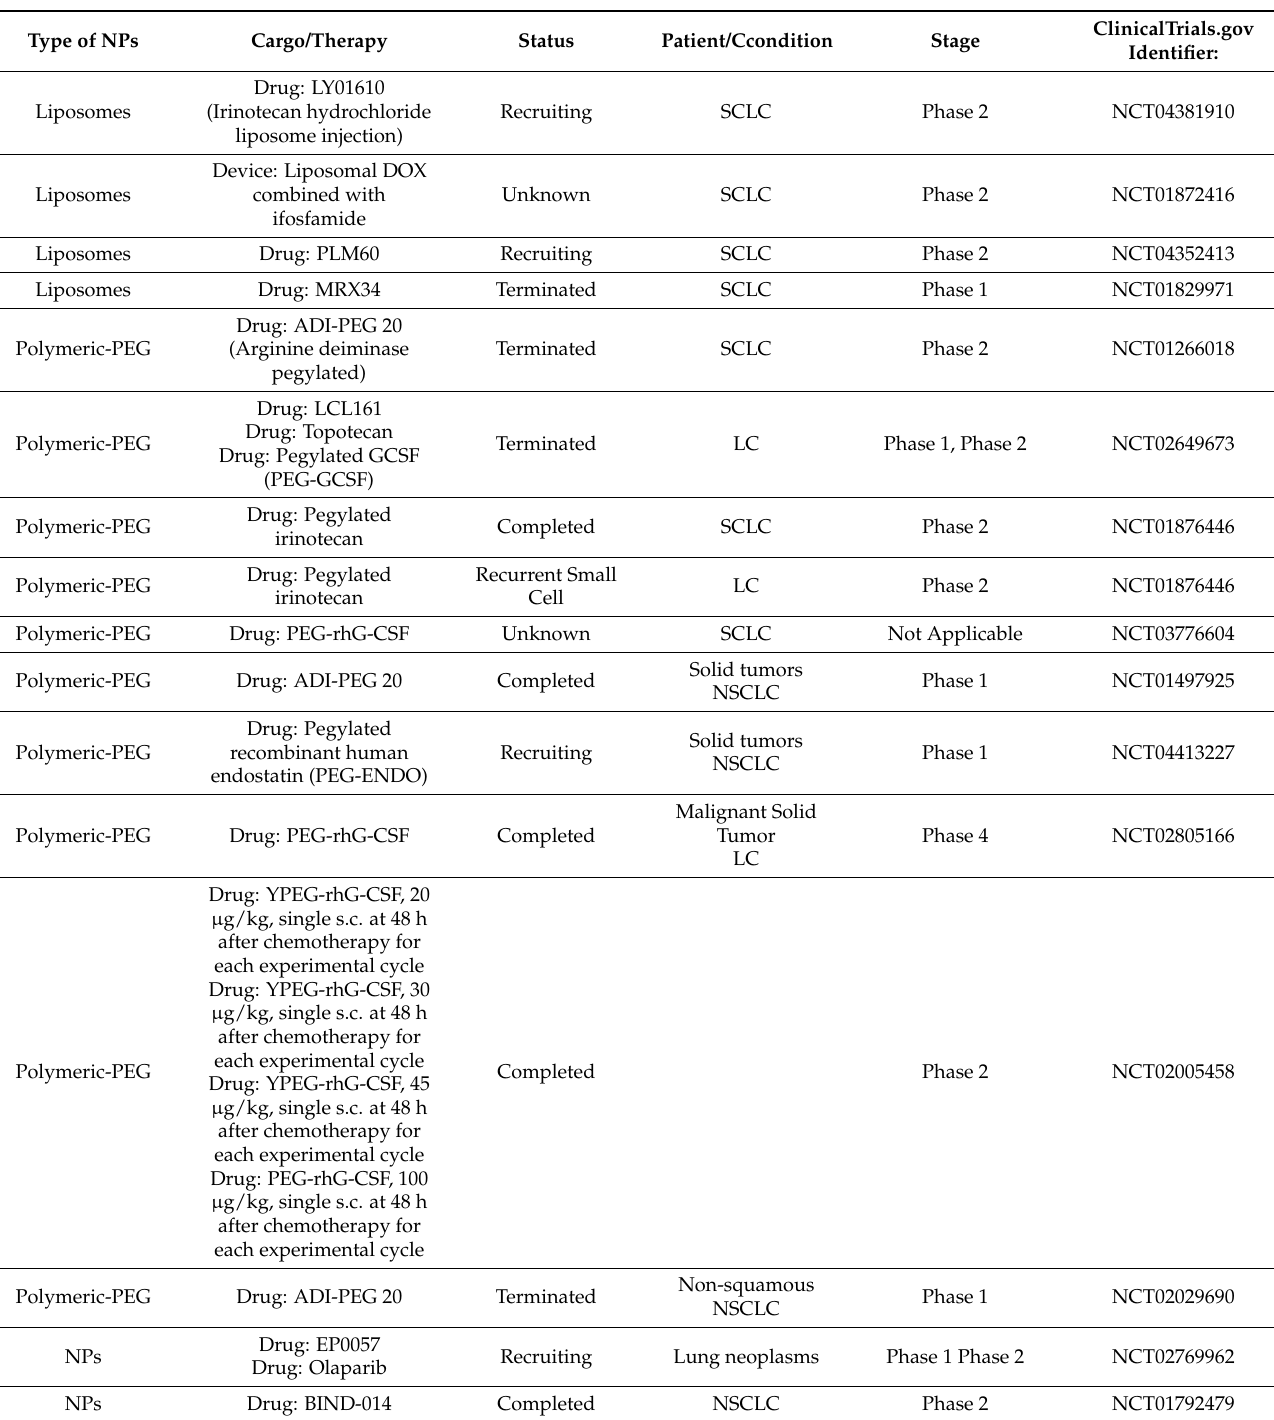
Table 2. Examples of clinical trials using nanocarrier-based DDS in treatment of LC.